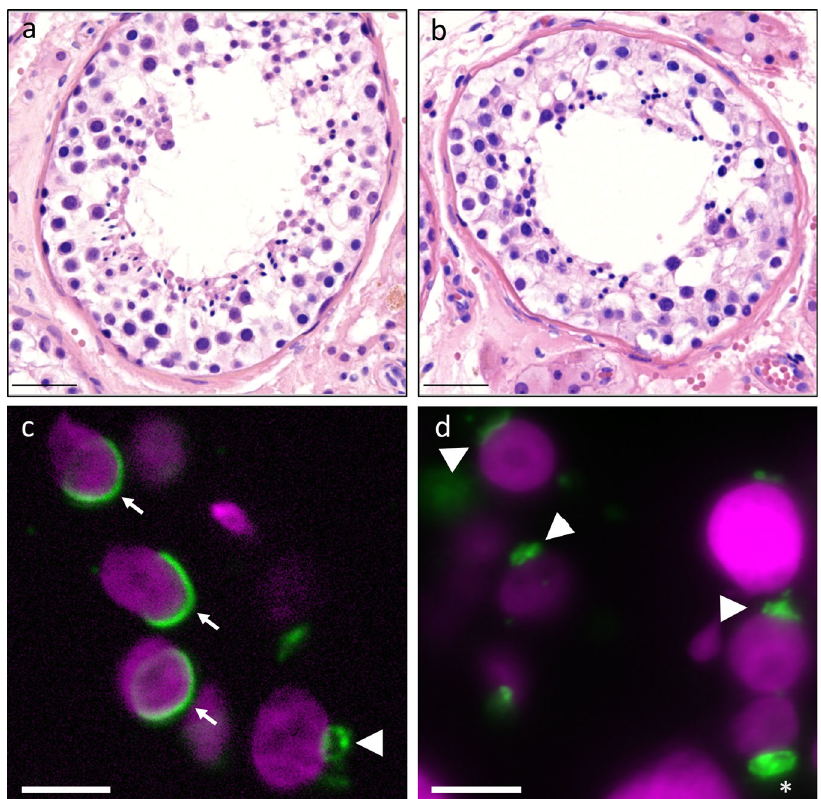
Fig. 3 Description of control and TOPAZ1 proband testis histology and aberrant acrosome formation. a , b H&E stainings of ( a ) control and ( b ) Proband_060 with pathogenic mutations in TOPAZ1 gene. The epithelium of the seminiferous tubules in the TOPAZ1 proband show reduced numbers of germ cells and an absence of elongating spermatids based on the analysis of 150 seminiferous tubules in control and patient. c , d immuno fl uorescent labeling of DNA (magenta) and the acrosome (green) in control sections ( c ) and TOPAZ1 proband sections ( d ). ( c ) The arrowhead indicates the acrosome in an early round spermatid and the arrows the acrosome in elongating spermatids. Spreading of the acrosome and nuclear elongation are hallmarks of spermatid maturation. ( d ) No acrosomal spreading (see arrowheads) or nuclear elongation is observed in the TOPAZ1 proband. The asterisk indicates an example of progressive acrosome accumulation without spreading. Scale bar: 40 µ m ( a , b ) and 5 µ m ( c , d